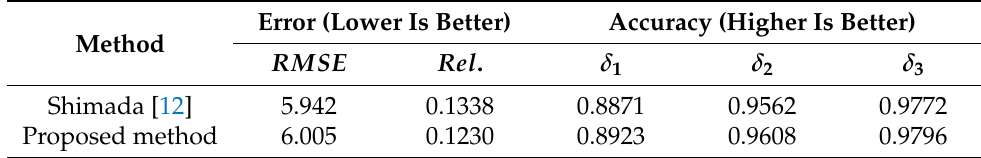
Table 3. Comparison to the state-of-the-art method using AirSim dataset.